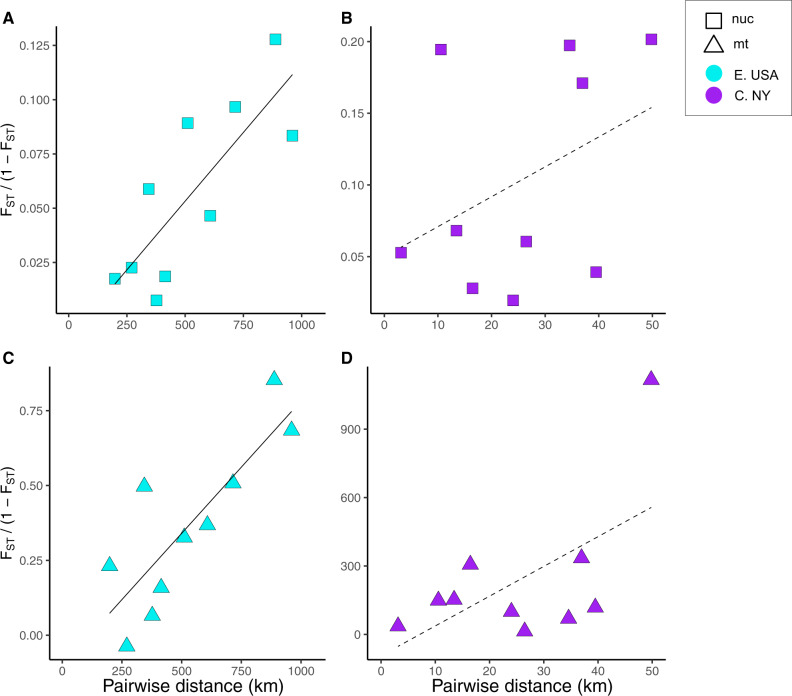
—Linearized pairwise whole-genome divergence versus geographic distance across the Eastern United States (A) and within the Central New York region (C. NY) (B) and pairwise mitochondrial divergence versus geographic distance across the Eastern United States (C) and within the Central New York region (D). Patterns of IBD are evident at both scales and for both types of markers. Nonsignificant regressions are illustrated with dotted lines.